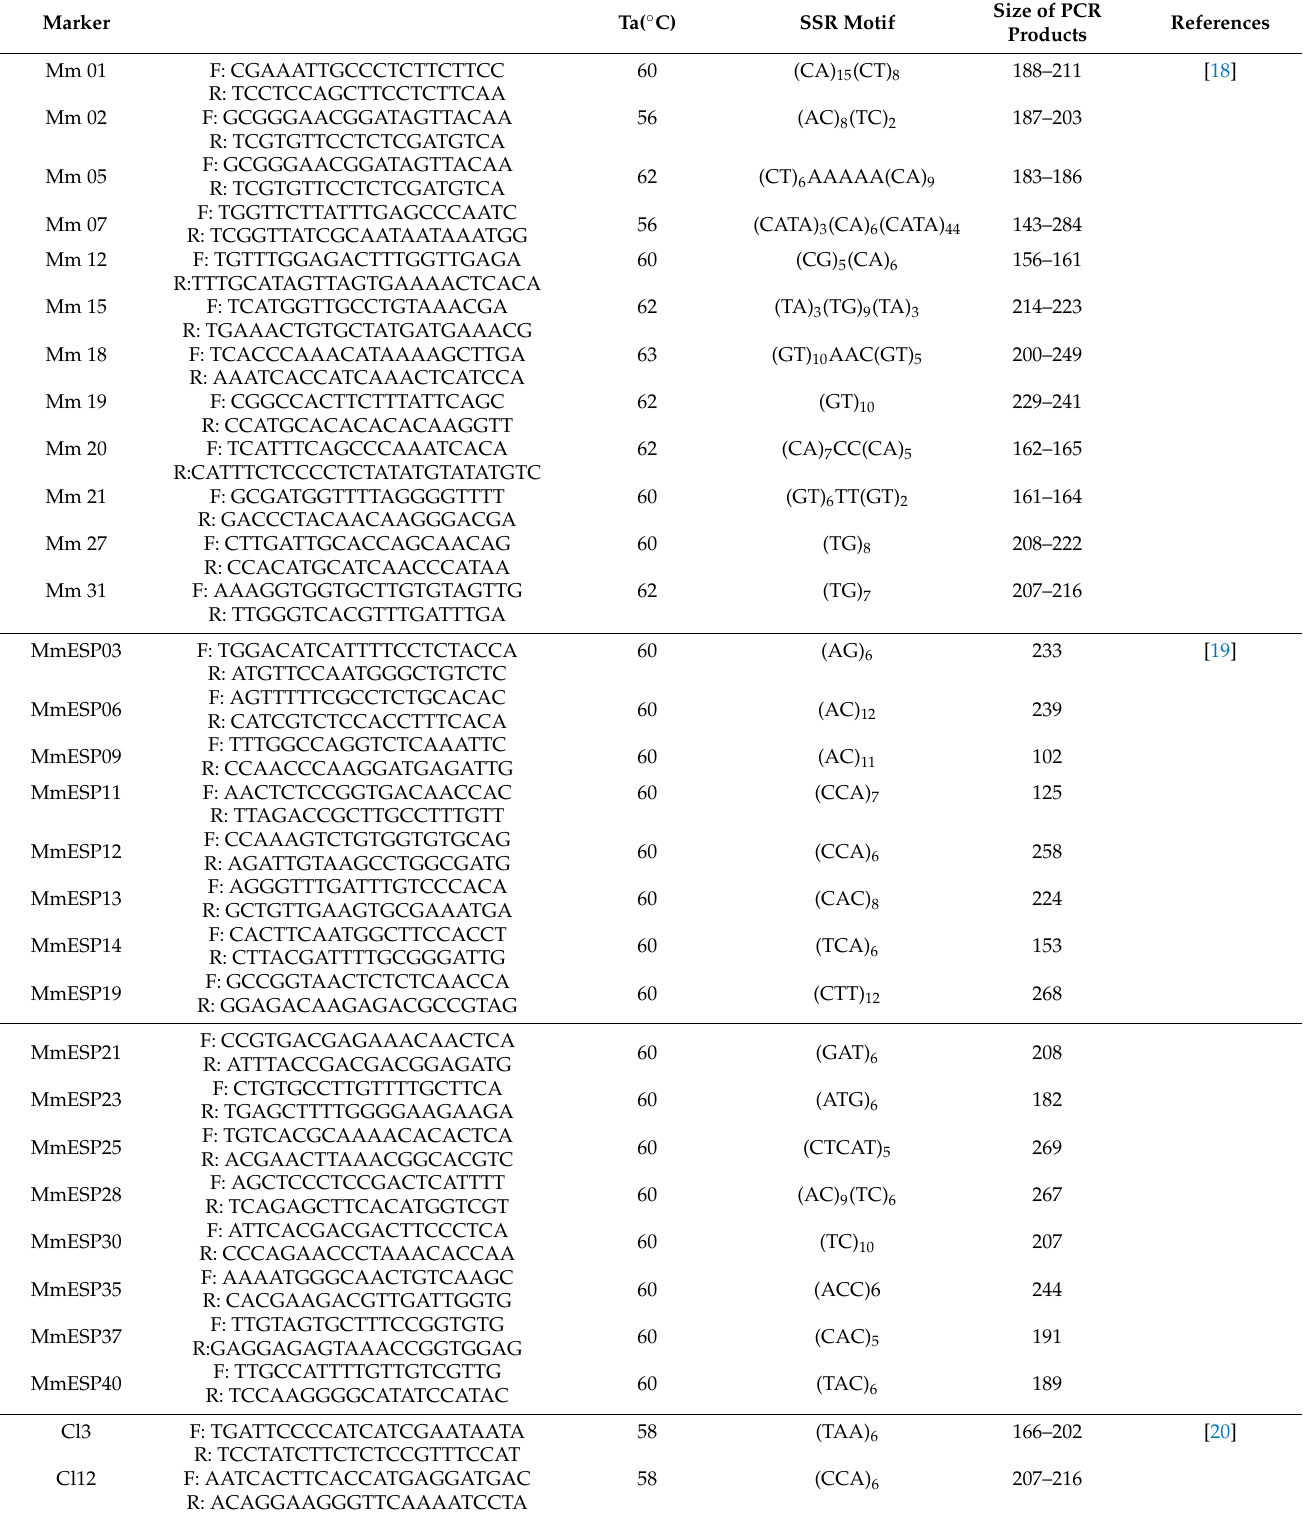
Table 2. Status of SSR primers